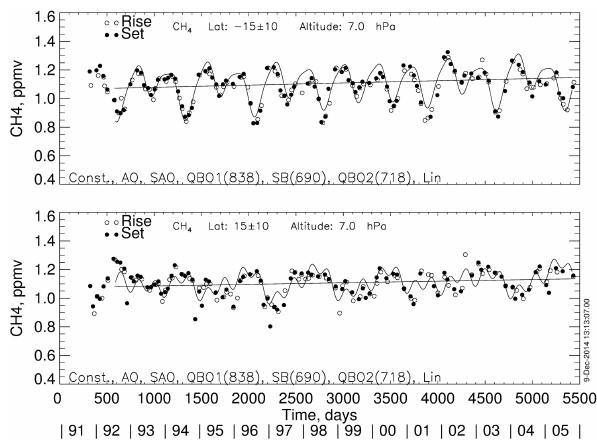
Figure 5. As in Fig. 3, but at 7hPa and at 15 ◦ latitude for the (top) Southern Hemisphere and for the (bottom) Northern Hemisphere.